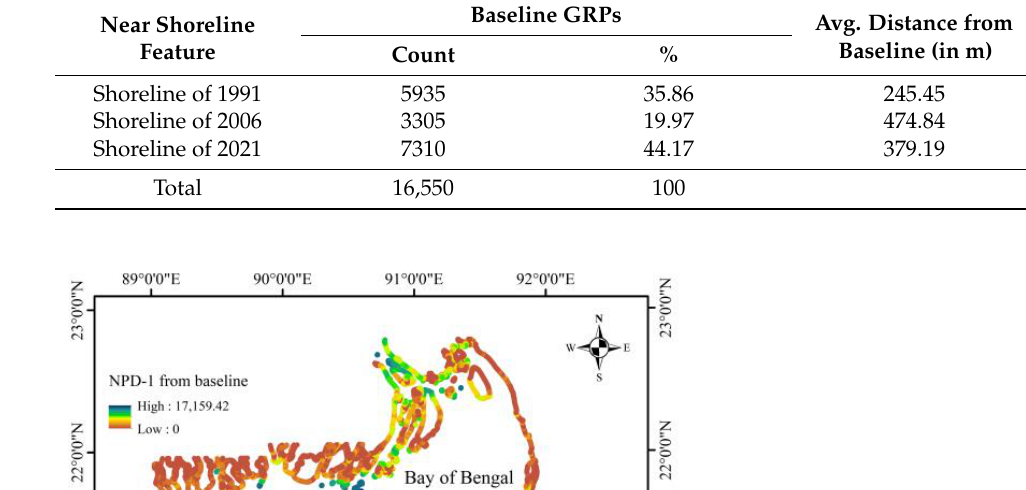
Table 4. Near feature analysis of the study baseline ground reference points (GRPs) for validation. Near Shoreline